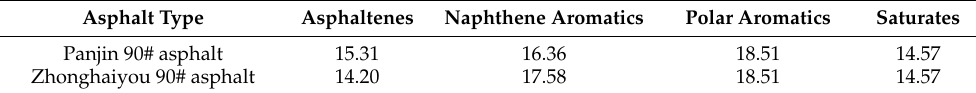
Table 2. Solubility of various asphalt components (J/cm 3 ) 1/2 .